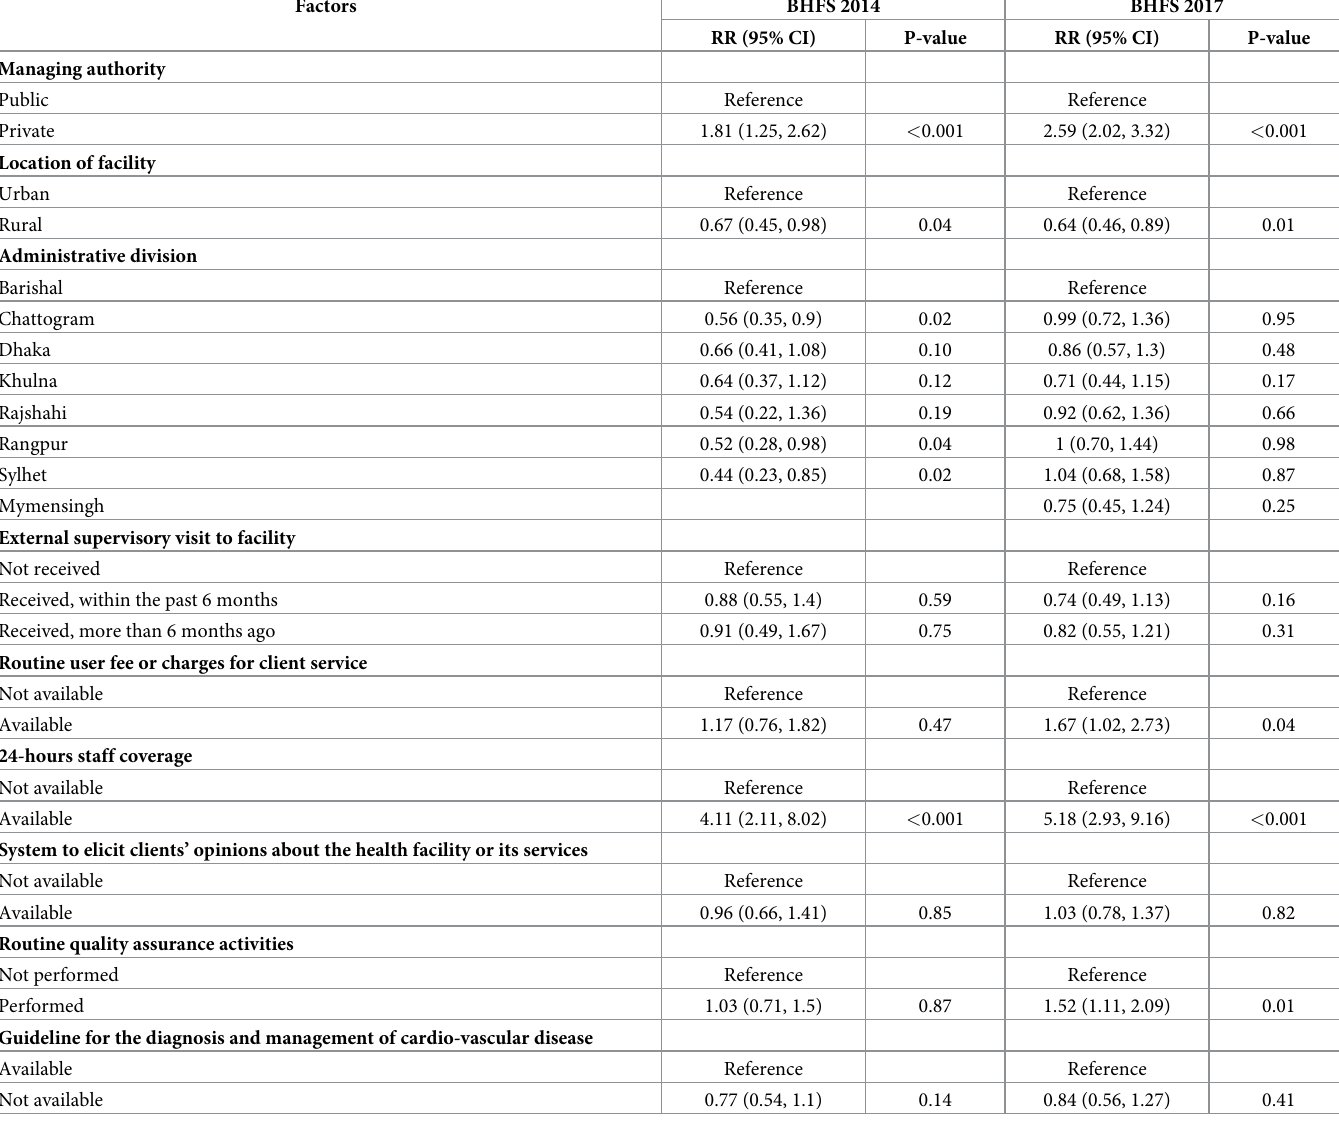
Table 2 indicates the factors associated with the EM-CVD availability using the Poisson regression model. The likelihood of EM-CVD availability scores was 81% more among the pri- vate facilities compared to public facilities in 2014 (relative risk (RR): 1.81, confidence interval (CI): 1.25–2.62, p-value: < 0.001). Also, similar findings were found for private facilities Table 2. The relative risk (RR), 95% confidence interval (CI), and p-values for the availability of essential medicines for CVD obtained using Poisson regression model, the 2014 and 2017 Bangladesh Health Facility Survey (BHFS).